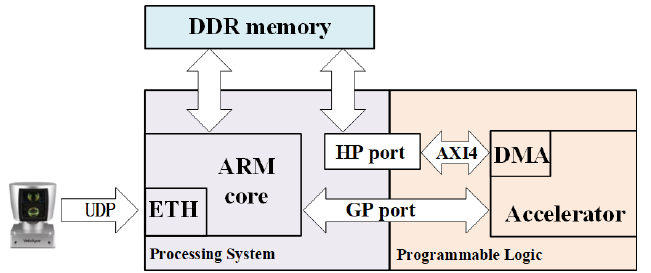
Figure 8. Overall system setup with LiDAR connected to the FPGA board directly.